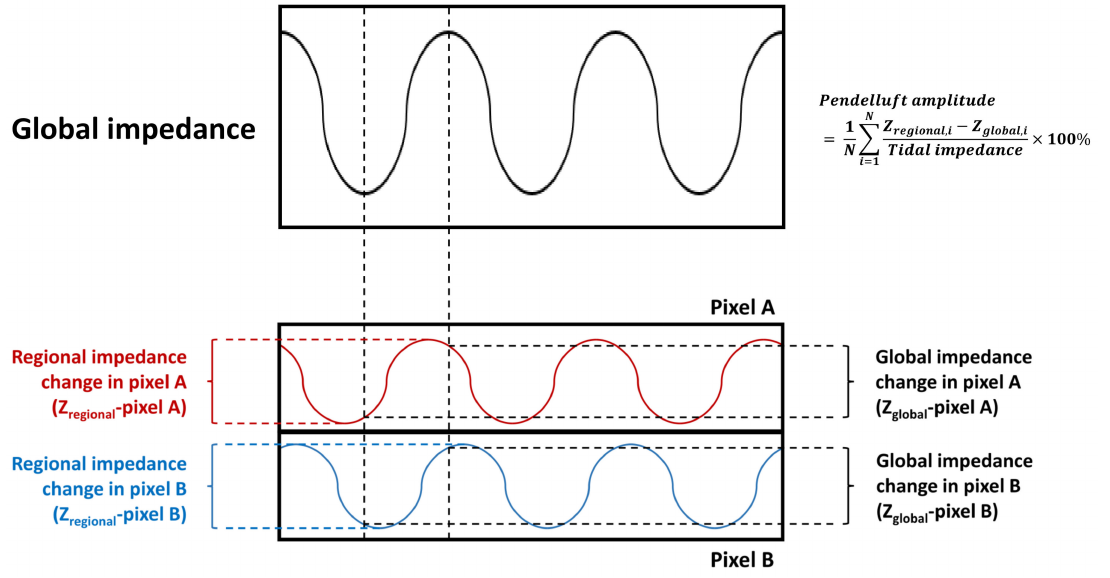
Figure 3. The estimation of pendelluft amplitude. The global impedance–time curve is presented in the upper column, and the timepoint of nadir impedance and peak impedance are recognized as the starting and ending points of inspiration (black dash line). The bottom column presents the impedance–time curve from two consecutive pixels. The regional impedance change of the pixel was defined by the impedance change in a breath cycle. Meanwhile, the global impedance change of the pixel was defined by the impedance difference in each pixel between the starting and ending timepoints of inspiration. The difference between regional and global impedance changes is summed as the pendelluft